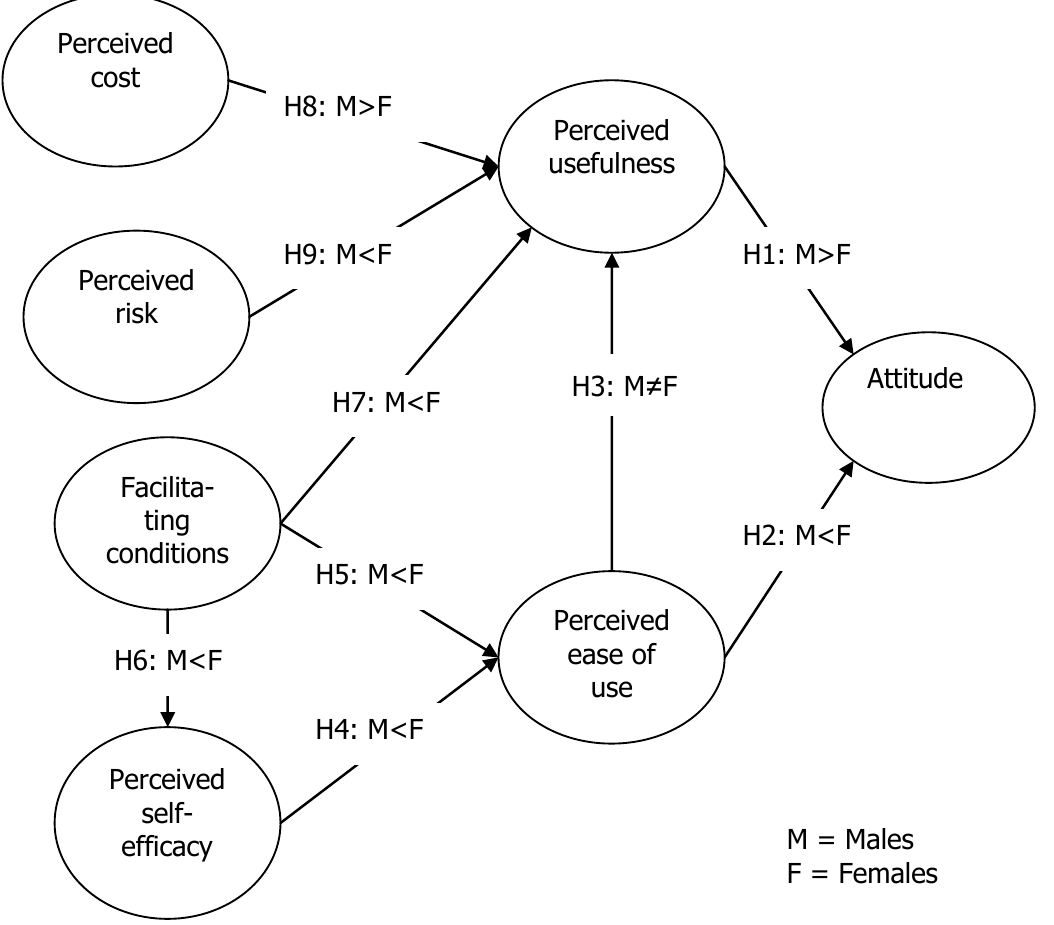
Fig. 1. Theoretical model of attitude formation towards WIG-cellphone